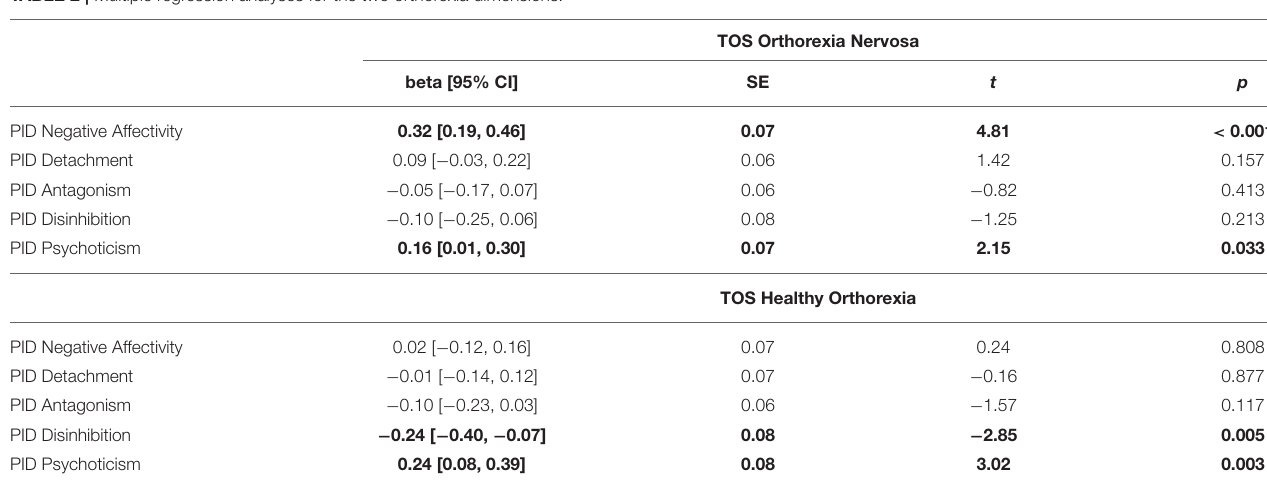
TABLE 2 | Multiple regression analyses for the two orthorexia